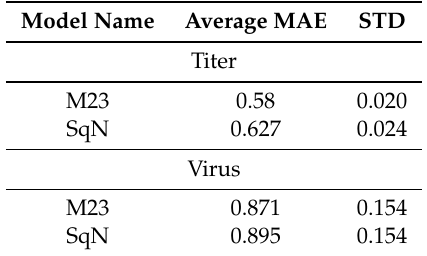
Table 4. Cross-validation results in terms of averaged Mean Absolute Error.